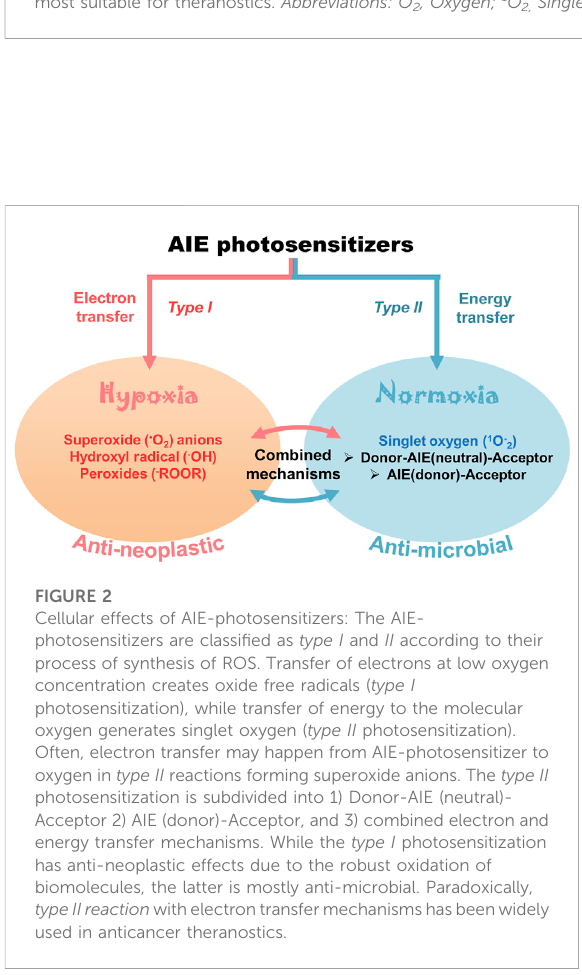
FIGURE 1 Mechanism of AIE-photosensitization: AIE-photosensitizers at the ground state (S0) absorbs energy to become excited Singlet states (S1, S2), which then undergoes Intersystem Crossing (ISC) to the Triplet states for thetransfer of electrons (T1) or energy (T2). Production of free radicals and singlet oxygen can be increased in T1 or T2 reactions by accelerating ISC from S1 to S2. Thus, it is ideal to have lower energy gap between S1 and S2 and a large spin-orbit coupling. Further, design of the AIE-photosensitizer molecules with a D-structure should allow aggregation-induced ISC. Unlike any other fl uorescent dyes, AIE-photosensitizers can overcome Aggregation-Induced Quenching (AIQ) in their condensed state and are most suitable for theranostics. Abbreviations: O 2 , Oxygen; 1 O 2, Singlet oxygen; ROS, Reactive Oxygen Species.